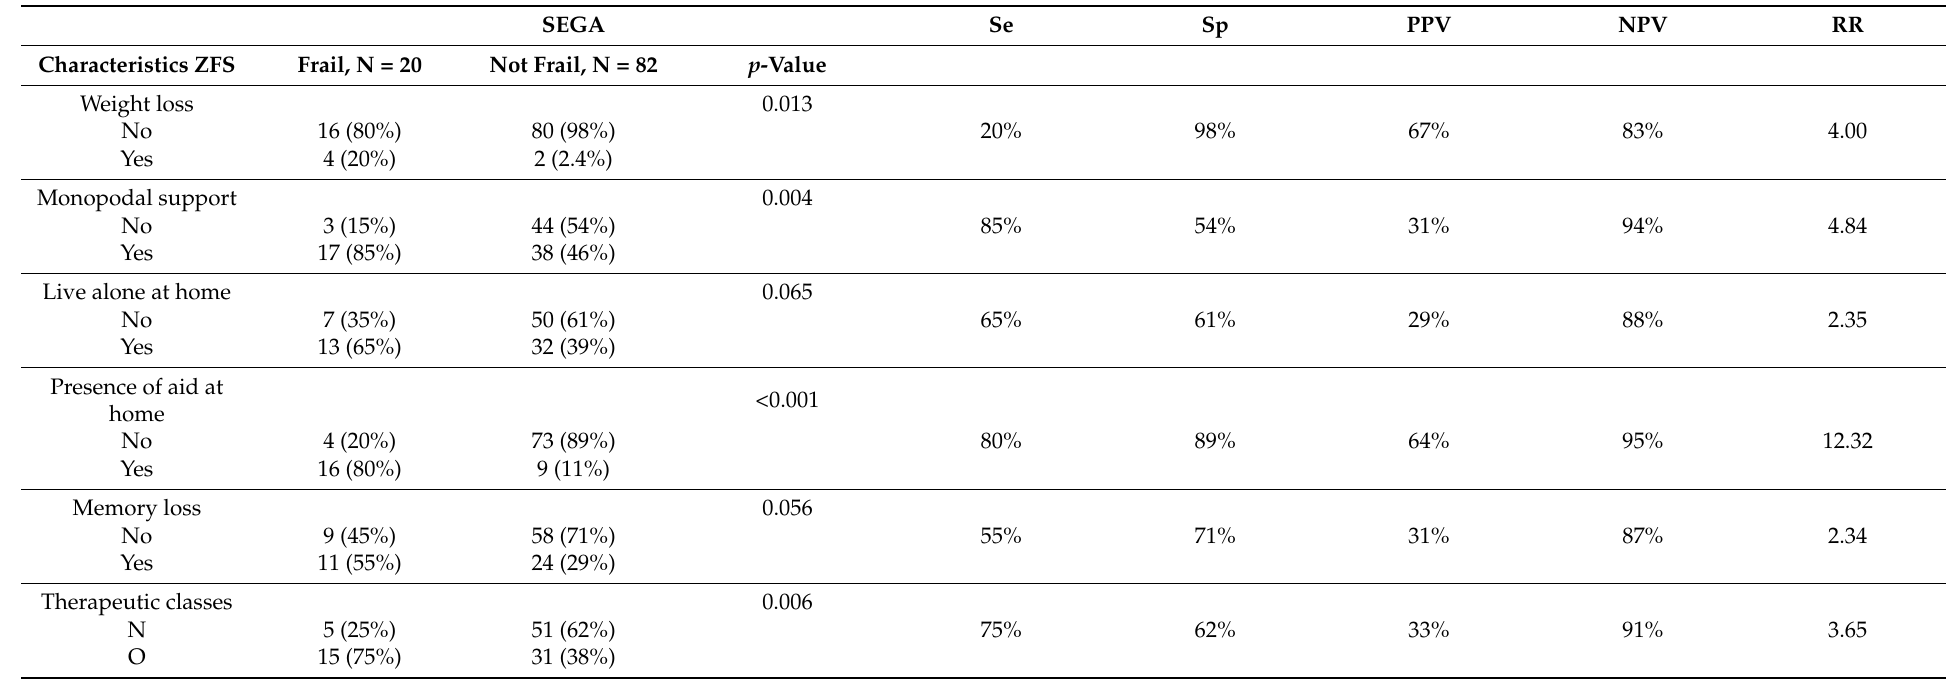
Table 8. Summary of all ZFS tool results compared to SEGA